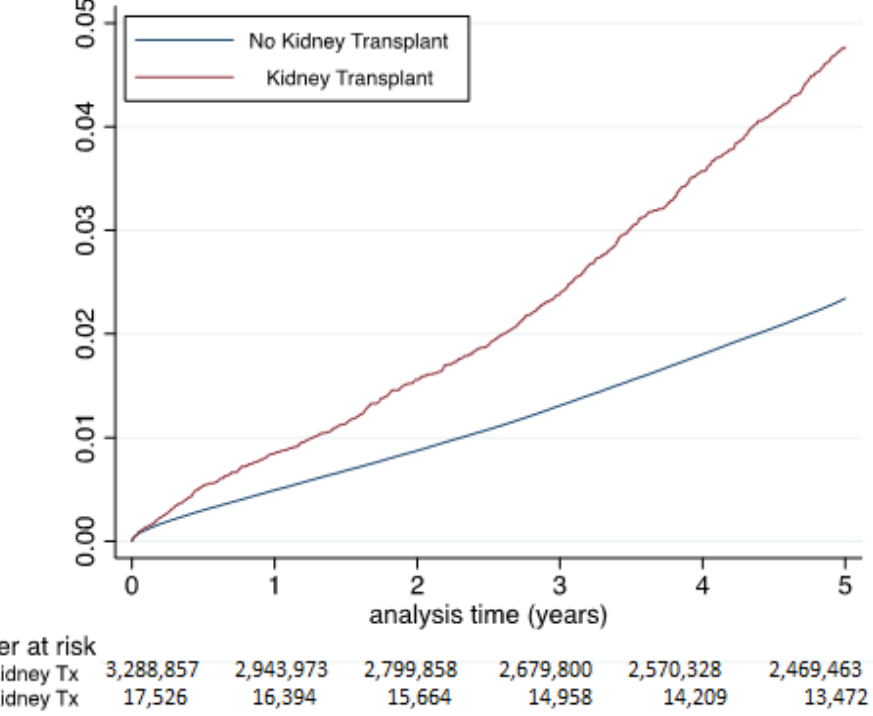
Figure 2. Cumulative incidence of myocardial infarction (MI) in patients seen in French hospitals in 2013 with at least five years of follow-up included in the study according to renal transplant (94,340 MI during follow-up of 4.6 ± 1.8 years, median 5.4, IQR 5.0–5.8 years). Hazard ratio 1.69, 95% CI 1.58–1.79 for renal transplant vs. no renal transplant. Adjusted hazard ratio 1.45, 95% CI 1.35–1.55, (adjustment on all characteristics of Table 1). Ordinate Axis = Incidence of myocardial infarction. (Kidney Tx = Kidney transplant; IQR = Interquartile Range)